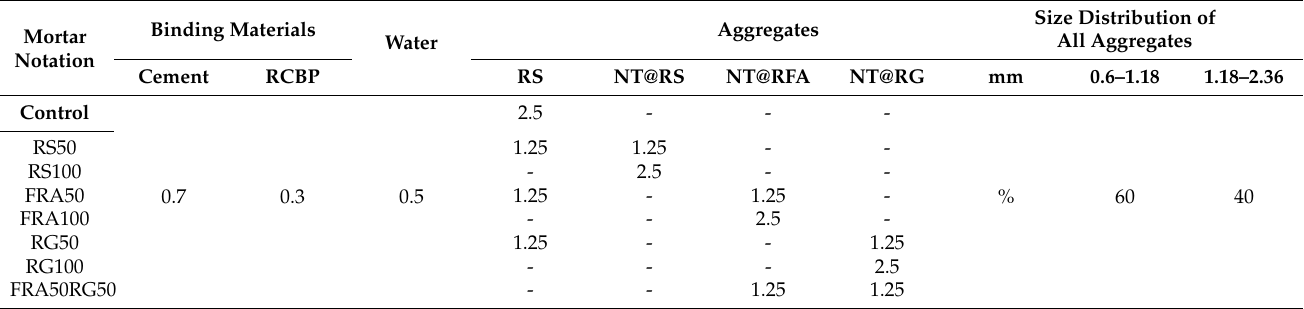
Table 3. Mix. proportion of photocatalytic mortars (for hardened